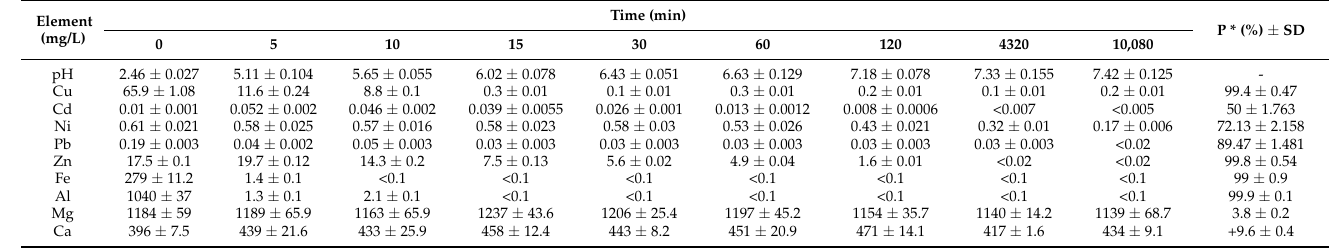
Table 4. Concentration of metals during the neutralization process of acid mine water with KOST fly